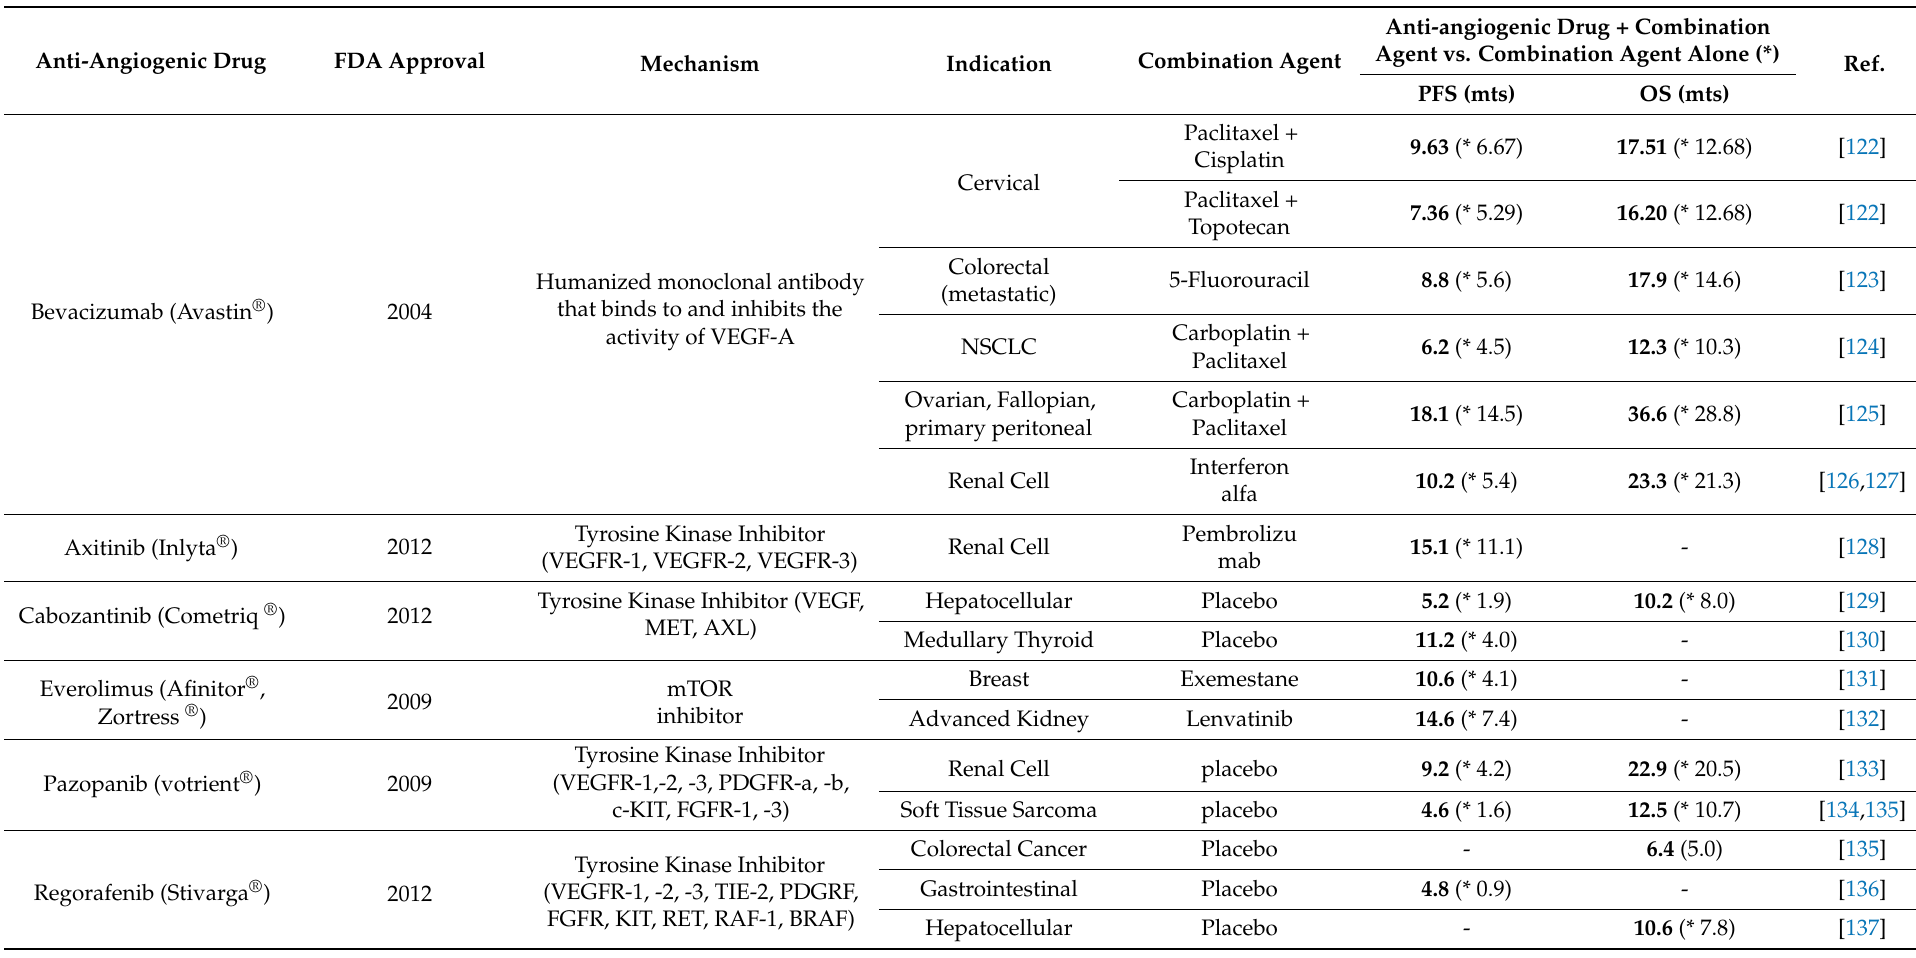
Table 1. Clinical success of FDA-approved anti-angiogenic drugs alone and in combination, as measured by progression free survival (PFS) and overall survival (OS).